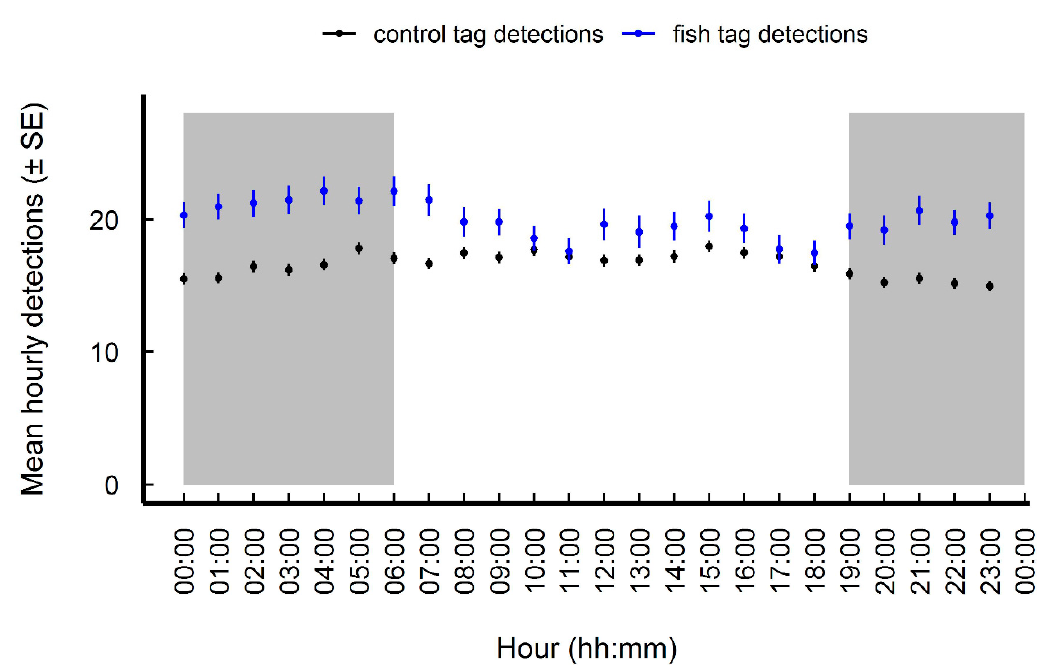
± se) of the tagged fish and control tags.